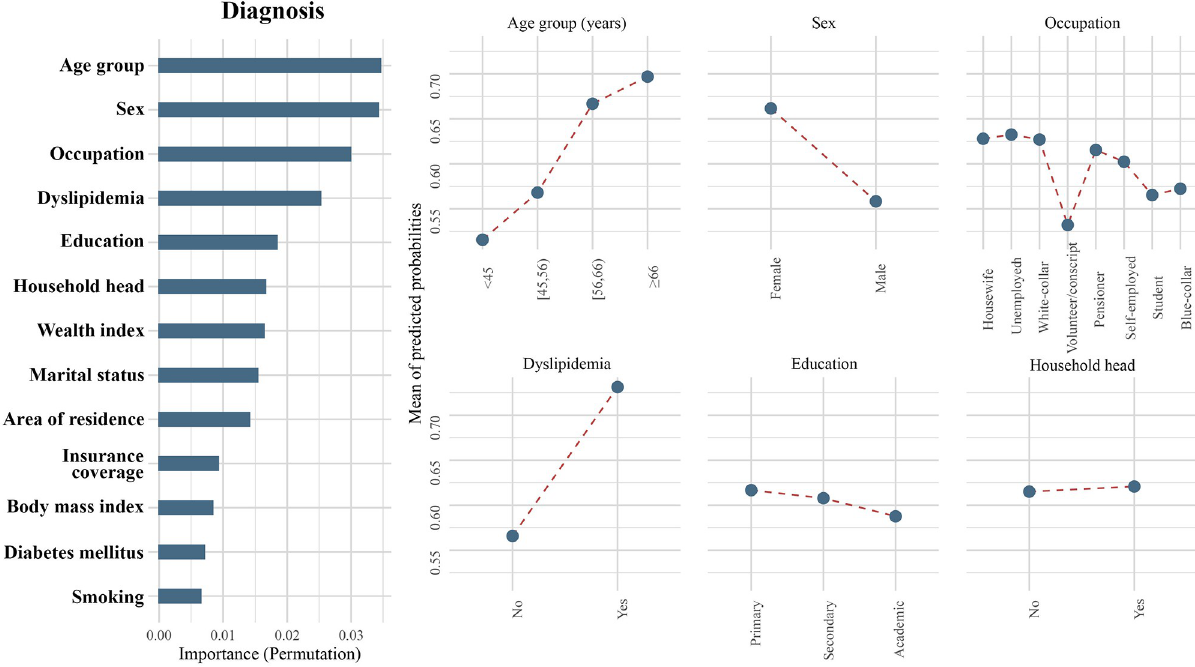
Fig 2. Importance of population characteristics and comparative probabilities of the top six important classifiers for diagnosis.